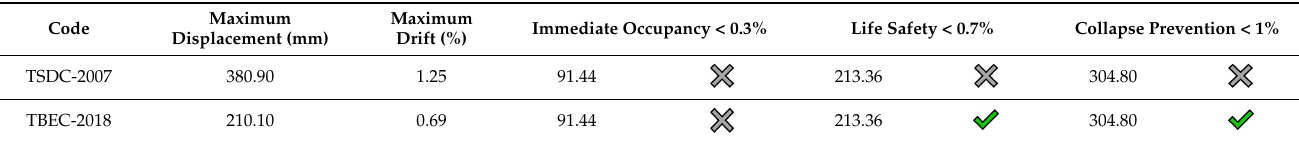
Table 12. Design earthquake drift check.